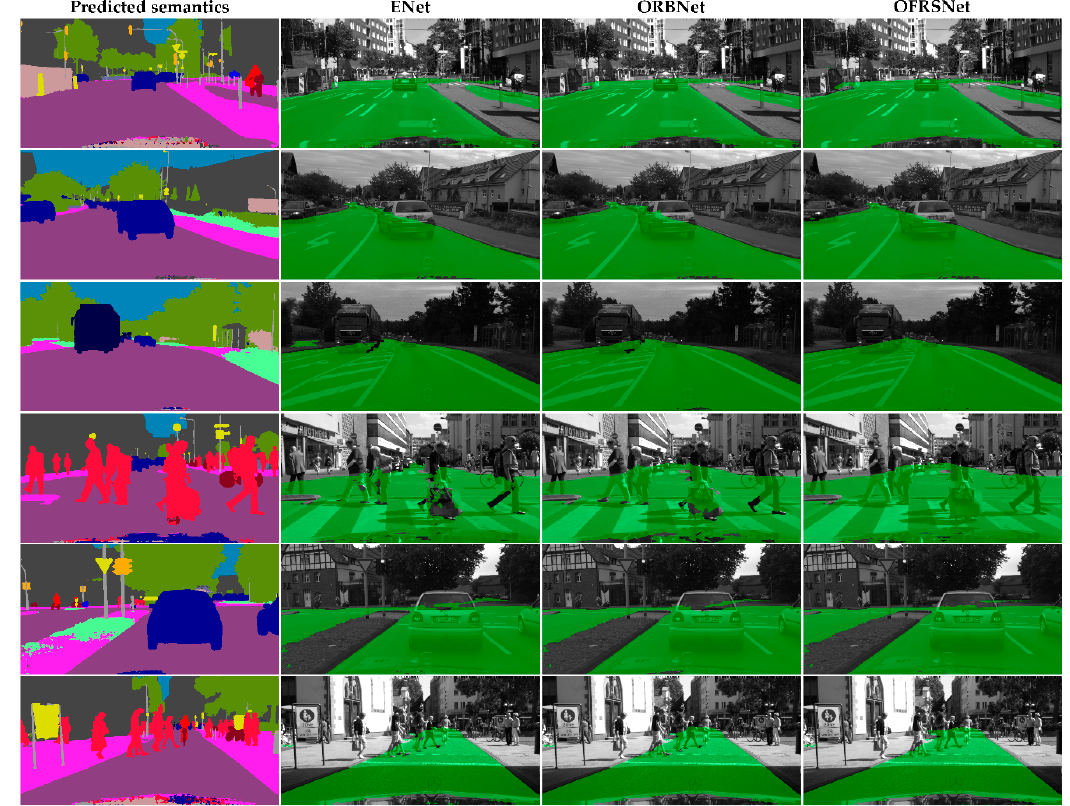
Figure 10. Qualitative results on the Cityscapes dataset using predicted semantics as input, which were obtained by the DeepLabv3+ algorithm. Green represents the detected full road area.